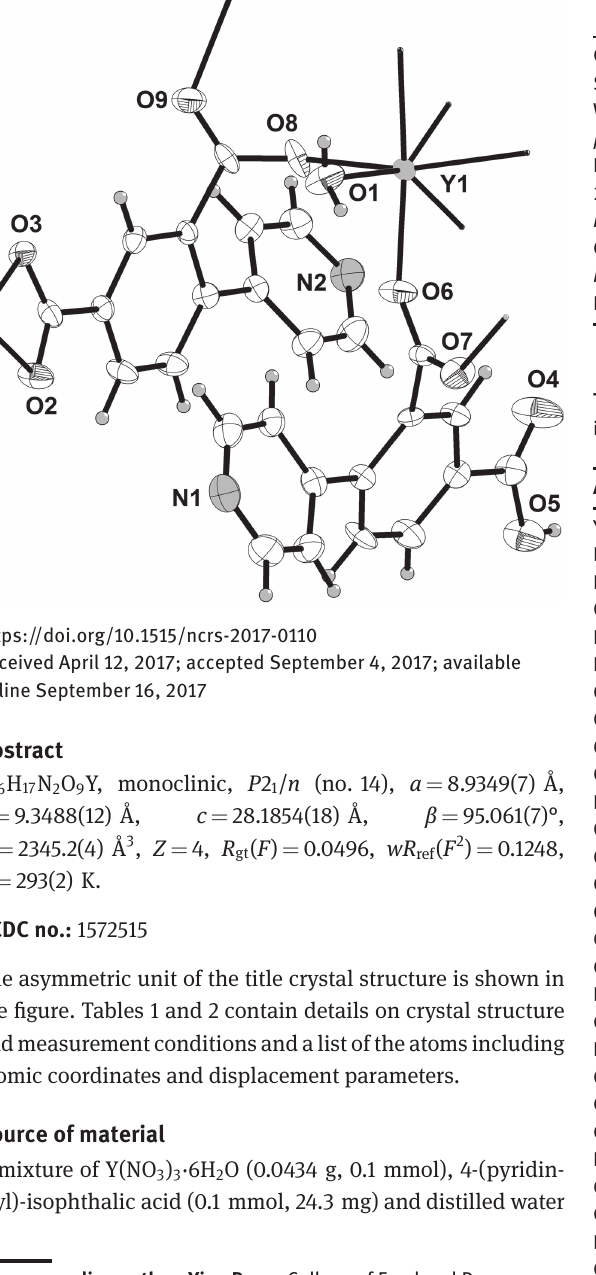
Table 1: Data collection and handling.